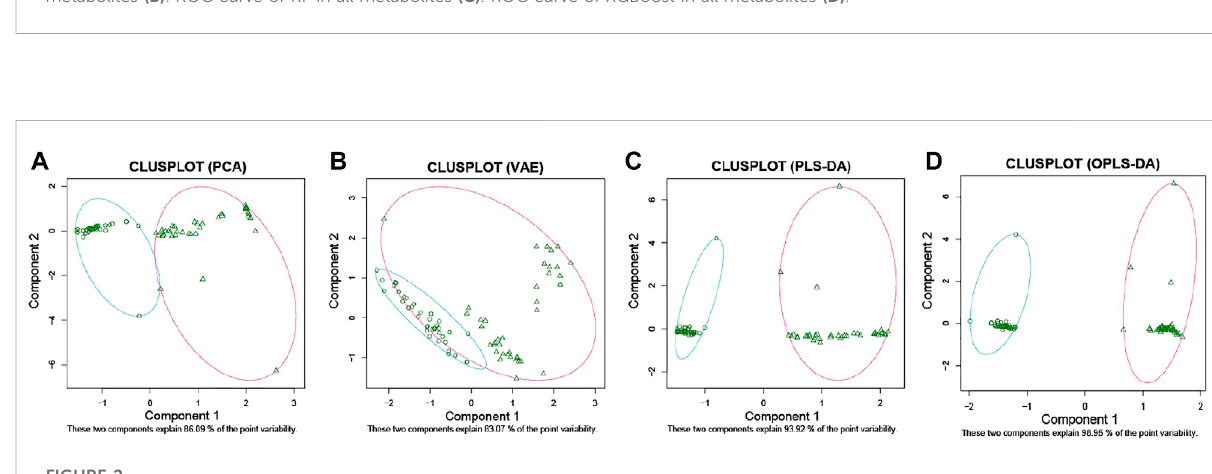
FIGURE 2 2D clustering plot based on PCA, VAE, PLS-DA, and OPLS-DA. PCA (A) . VAE (B) . PLS-DA (C) . OPLS-DA (D) .